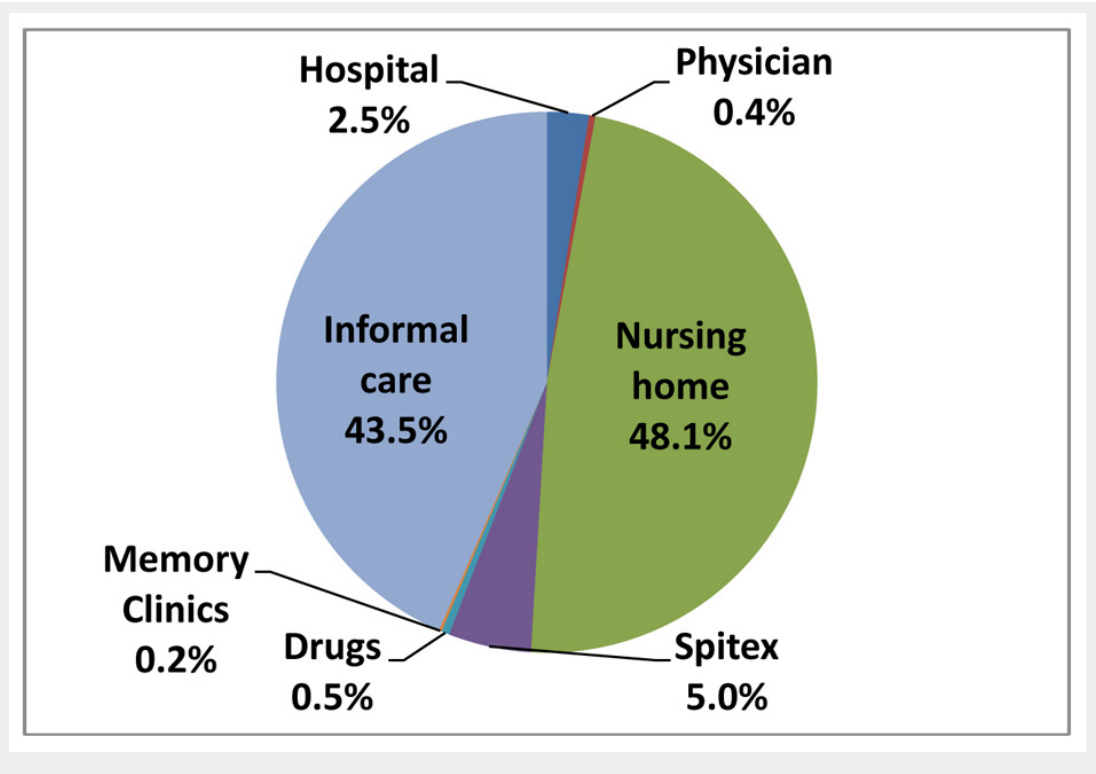
Figure 3 Estimated cost distribution in the year